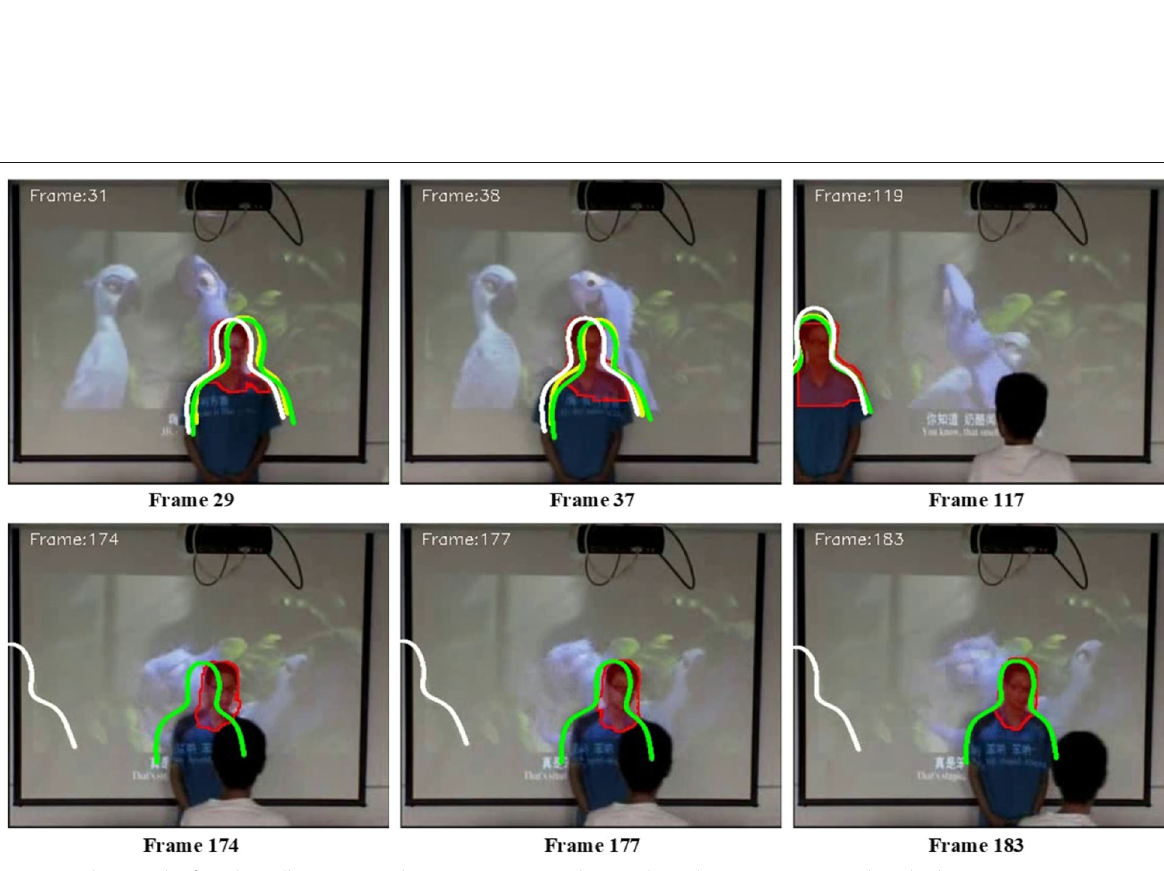
Fig. 6 Tracking result of “ Body. ” Yellow — UKPF, white — MHMM-UPF, red — Hough Tracker, green — proposed